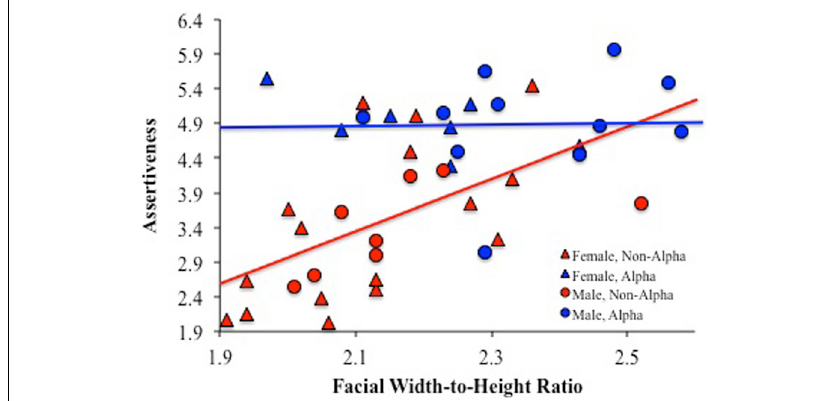
FIGURE 1 | Alpha status moderates the relationship between facial width-to-height ratio and assertiveness in capuchin monkeys. Data from Lefevre et al. (2014). Note: the blue regression line represents the relationship between facial width-to-height ratio and assertiveness in alpha monkeys and the red regression line represents the relationship between facial width-to-height ratio and assertiveness in non-alpha monkeys. Alpha males ( n = 11), r = 0 . 22, p = 0 . 52; Non-alpha males ( n = 8), r = 0 . 58, p = 0 . 13; Alpha females ( n = 7), r = − 0 . 62, p = 0 . 14; Non-alpha females ( n = 17), r = 0 . 58, p = 0 .